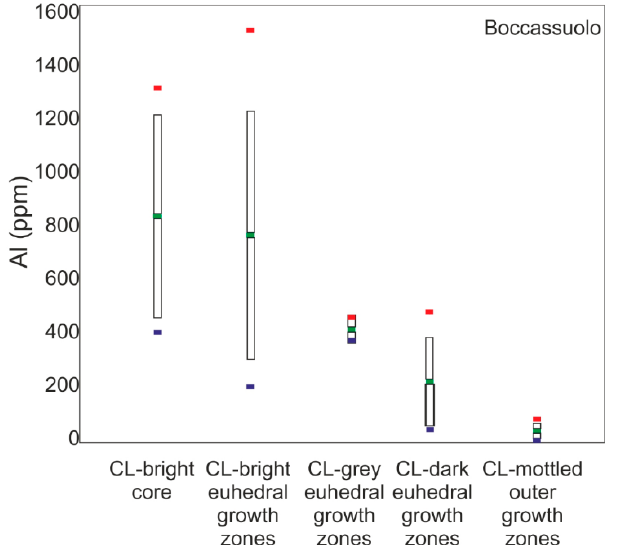
Figure 6. Al content of quartz (Qtz 1) with different CL signatures. Some positive correlation is observable (Boccassuolo) (legend: red: max; green: mean; blue: min concentrations; rectangles: standard deviation).